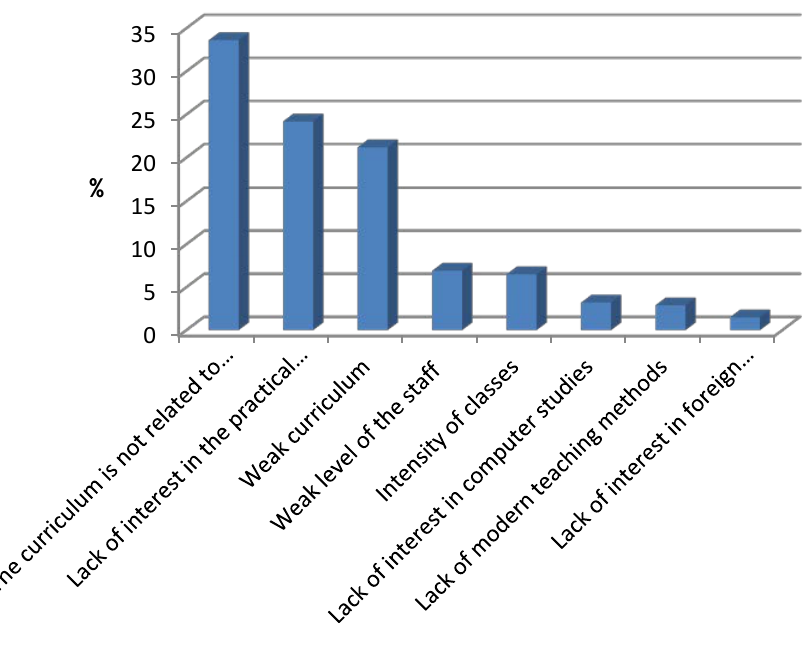
Figure 2: The percentage distribution of the causes of imbalances in the educational system. Source: Own elaboration based on the Survey of IDSC,